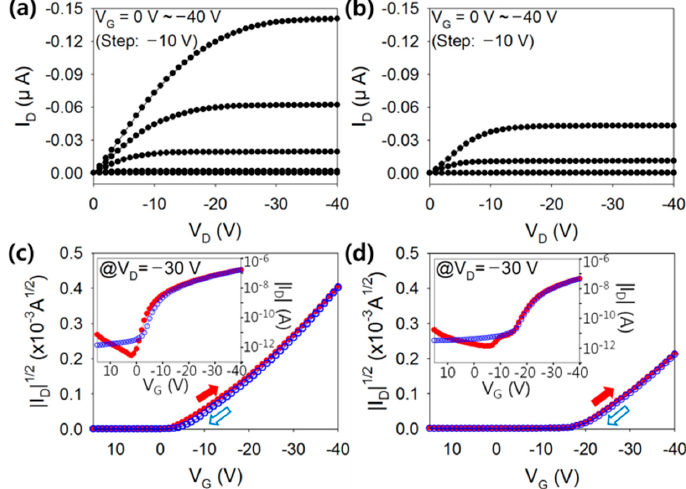
Figure 2. Output characteristics of the flexible TIPS-pentacene TFTs with the ( a ) c-PVP/Y 2 O 3 composite and ( b ) c-PVP gate insulators | I D | vs. V G and | I D | 1/2 vs. V G plots of TIPS-pentacene TFTs with the ( c ) c-PVP/Y 2 O 3 composite and ( d ) c-PVP gate